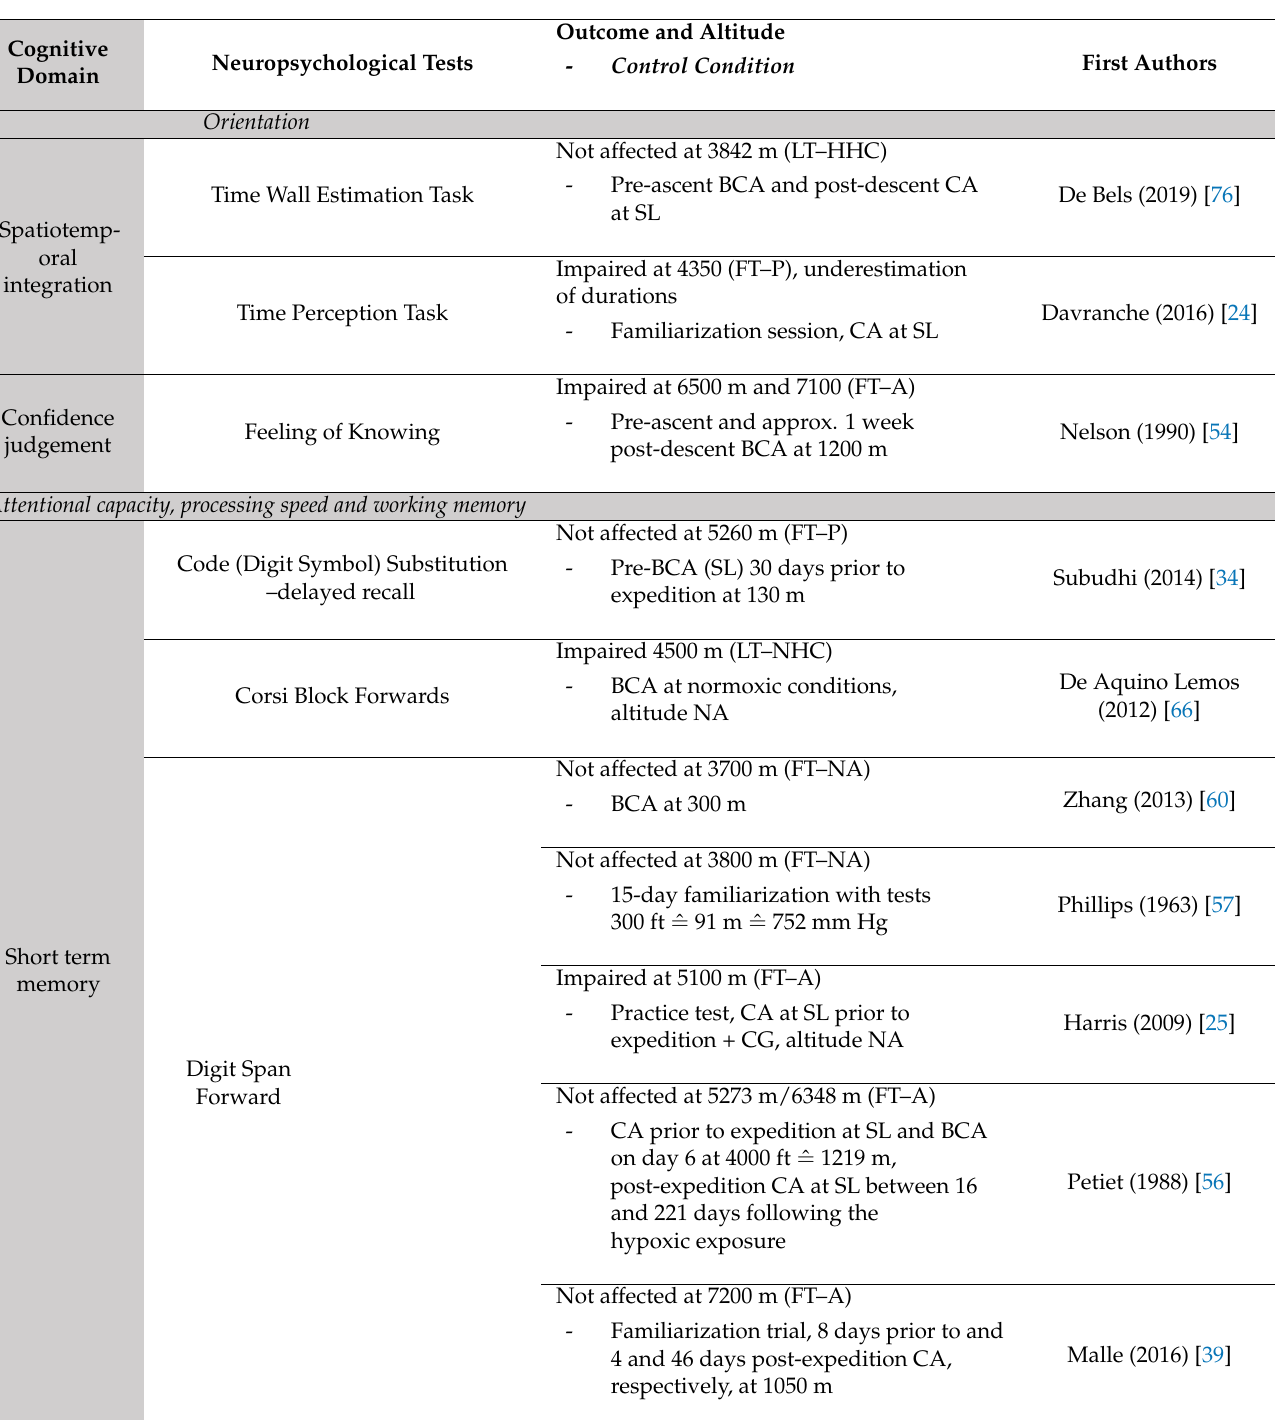
Table 2. Classification of neuropsychological tests into supercategories of cognitive domains supple- mented by article and brief